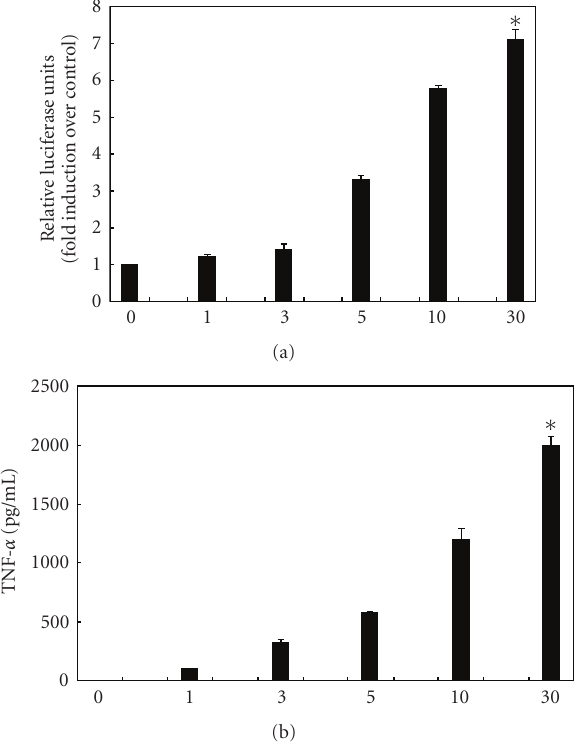
Figure 1: Treatment with fraction V bovine serum albumin (BSA) (Sigma-Aldrich, St. Louis, Mo) dose-dependently increases TNF- α gene expression in murine peritoneal macrophages in an NF- κ B-dependent manner. (a) RAW264.7 peritoneal macrophages were transiently transfected with a 3x NF- κ B/luc reporter plasmid prior to treatment with increasing doses of BSA for 24h (doses in mg/mL shown on the x -axis). BSA treatment resulted in increased NF- κ B activation in a dose-dependent manner. As a comparison, LPS treatment (10 μ g/mL) resulted in a 3.9-fold increase in relative luciferase activity ( data not shown ).All experiments were performed in triplicate with 3 wells per condition ( ∗ P < . 05 compared to control). (b) RAW264.7 peritoneal macrophages were treated with increasing doses of BSA for 24h (doses in mg/mL shown on the x -axis). BSA treatment resulted in a significant increase in TNF- α , as measured by ELISA. As a comparison, LPS treatment (10 μ g/mL) resulted in a much greater increase in TNF- α compared to BSA (TNF- α 7000pg/mL) ( data not shown ). All experiments were performed in triplicate with 3 wells per condition ( ∗ P < . 05 compared to